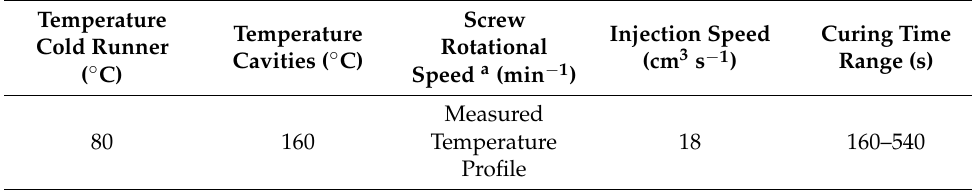
Table 2. Simulation settings of the injection molding process; Here, a indicates that the screw rotational speed has to be considered in those simulation runs only where a measured profile of the mass temperature was applied. Thermal conductivity: steel λ S = 39 Wm − 1 K − 1 , heat